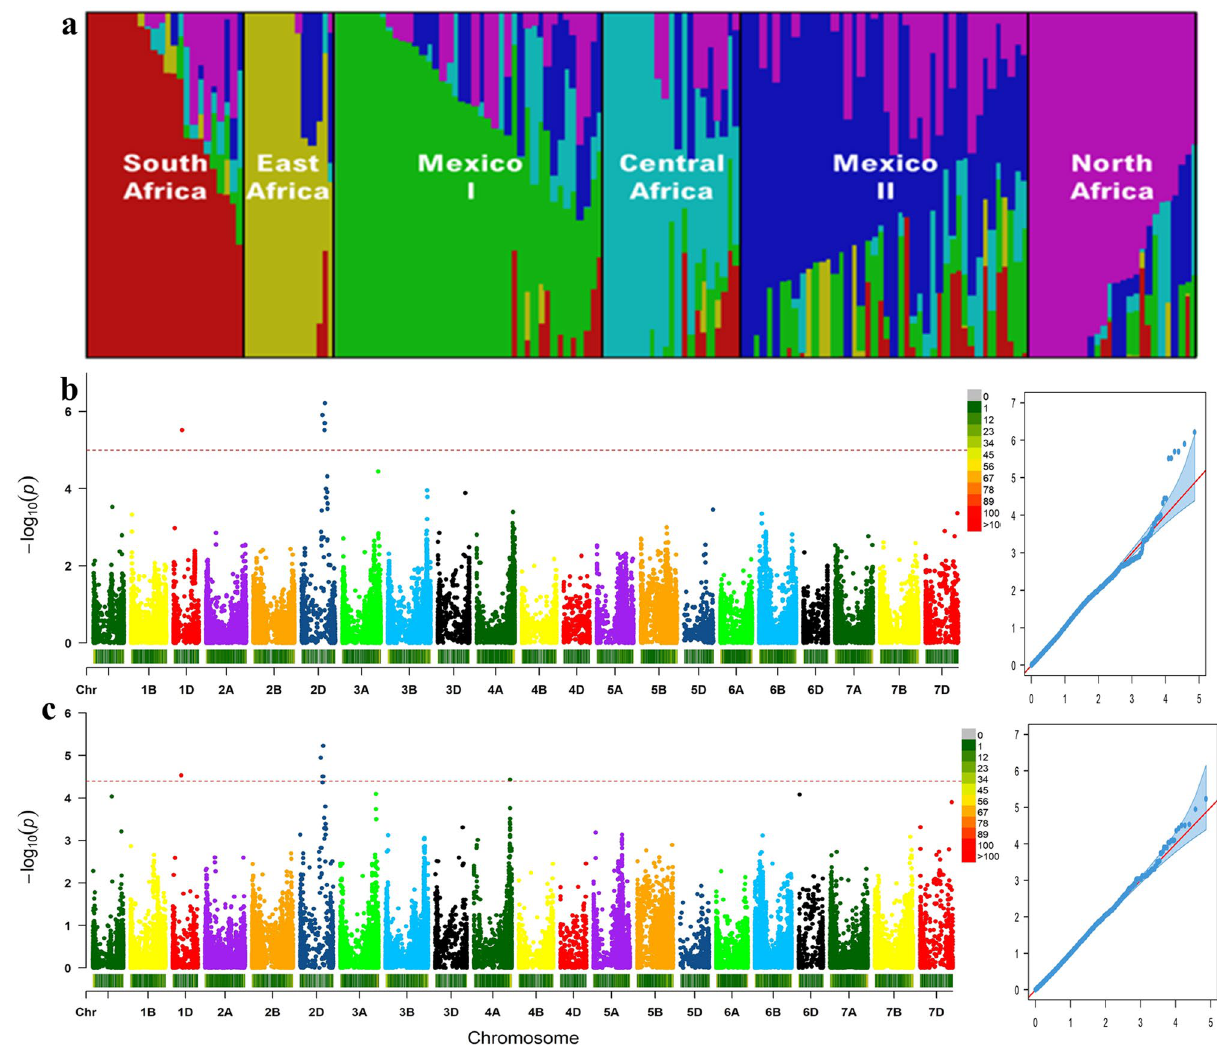
Figure 3. Population structure of 157 hexaploid wheat cultivars and genome-wide association studies of grain traits ( a ). Manhattan and Q–Q plots indicate the degree of association between SNPs and grain length ( b ) or grain width ( c ). Population structure plot and Manhattan/Q-Q plots were generated using fastSTRU CTU RE version 1.0 (https:// rajan il. github. io/ fastS truct ure/) and GAPIT version 2 (https:// pubmed. ncbi. nlm. nih. gov/ 27898 829/),